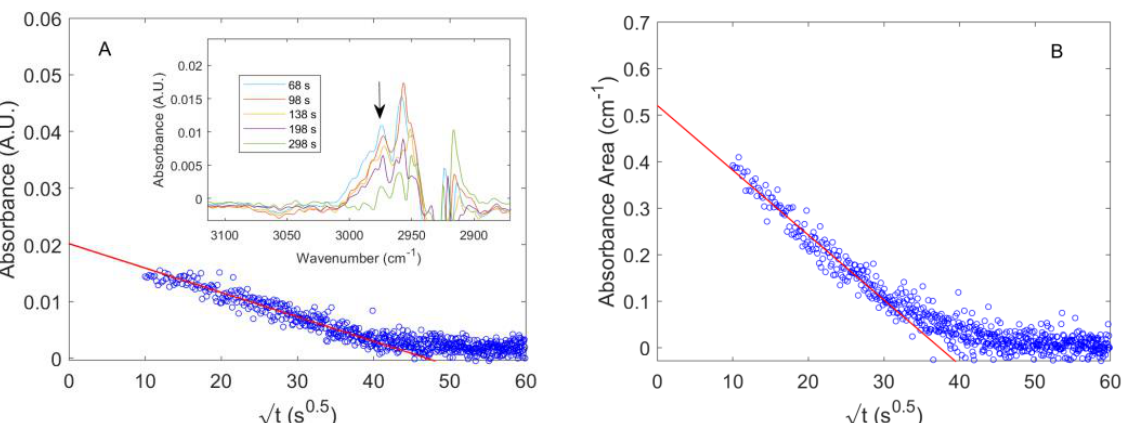
Figure 7. Integral desorption kinetics of CH 4 from PPO. The initial pressure is equal to 753.5 Torr. ( A ) Absorbance at 2973 cm −1 ; ( B ) absorbance area in the range [2969,3005] cm −1 .